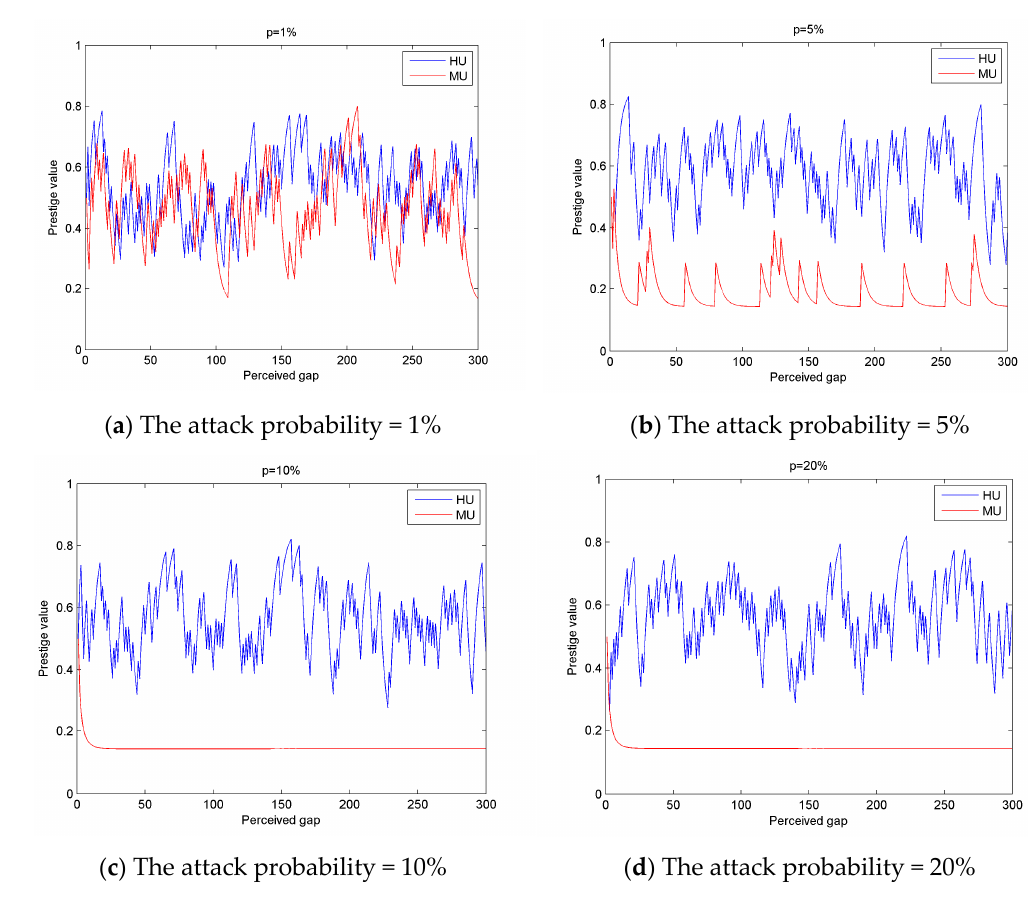
Figure 4. The change in reputation value of cognitive users with different attack probabilities with sensing intervals.